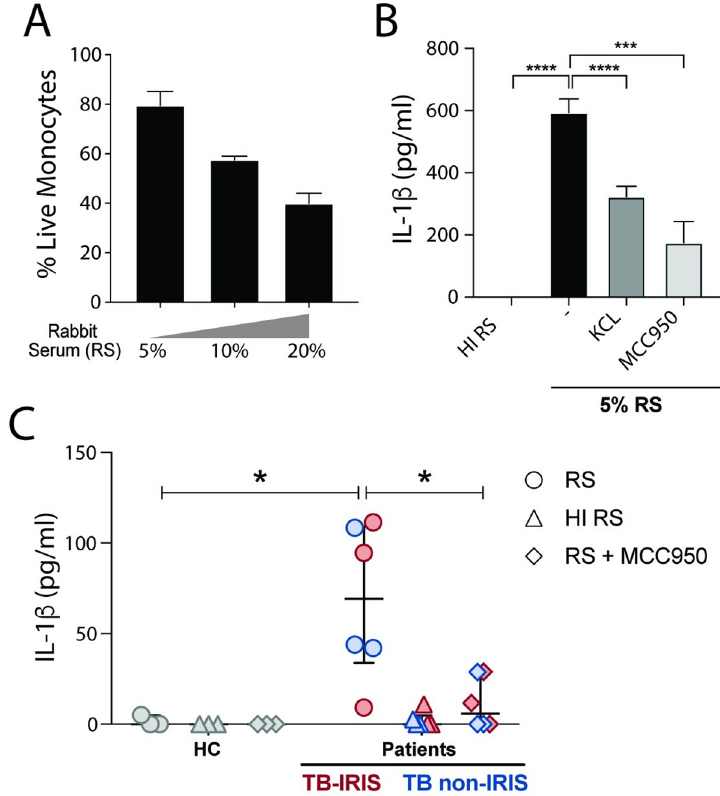
Fig 6. Effect of exogenous complement-mediated inflammasome activation on HCs and patient cells. (A) Absolute numbers of healthy control human monocytes stimulated with designated concentrations of rabbit serum (RS) or heat- inactivated (HI)-RS (30 min at 56˚C) for 2 hours, were enumerated by using counting beads by flow cytometry. HI-RS-stimulated cultures were considered 100% viable. (B) IL-1 β secretion of 5% RS or 5% HI-RS-stimulated healthy control monocytes was determined at culture supernatants by ELISA. Cells were treated or not with the NLRP3 inhibitor, MCC950 (3 μ M) or with KCl (10 mM) solution. Numbers represent the means ± SEM ( n = 3). ���� P < 0.001 when compared with control or untreated groups. Data are representative of three independent experiments. (C) IL-1 β secretion by PBMCs from three different HCs, TB non-IRIS or TB-IRIS patients, at IRIS timepoint, was determined by ELISA after cells were incubated or not with MCC950 (3 μ M) and exposed to 3% of RS or HI-RS for 2 hr. Data are presented as median with interquartile range. � P < 0.05 when compared with control or untreated groups after Mann- Whitney test was